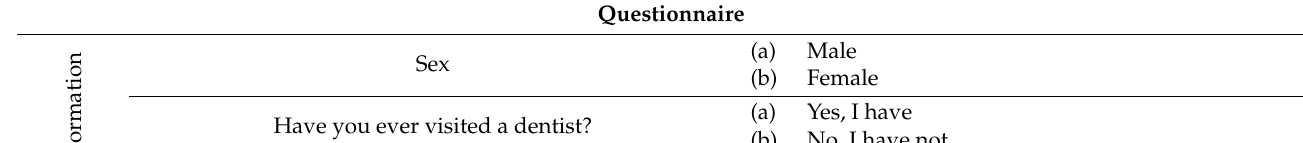
Table 1. Complete questionnaire subjected to all